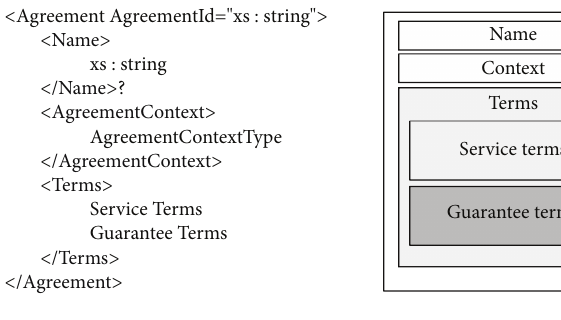
Figure 2: Structure of an